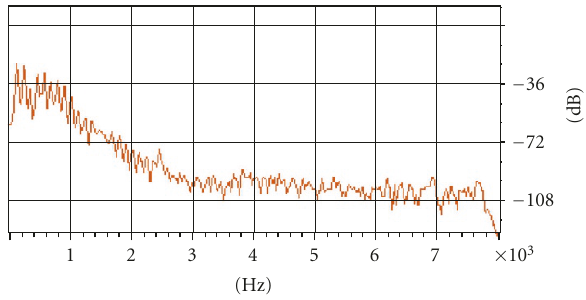
Figure 18: Normal speech long-term spectrum—NAM micro-